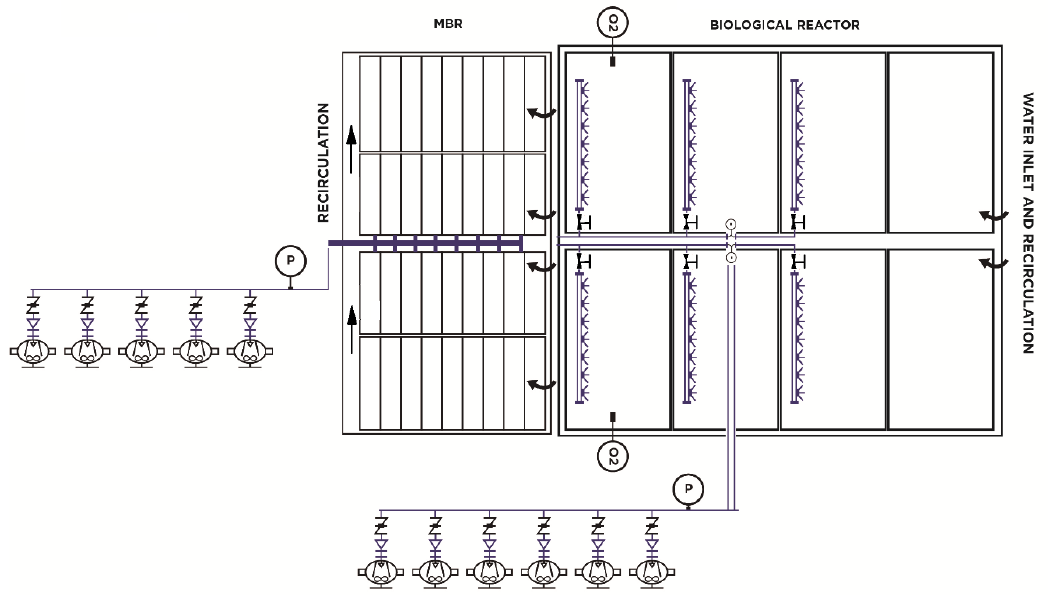
Figure 1. Initial process flow diagram of aeration operation.